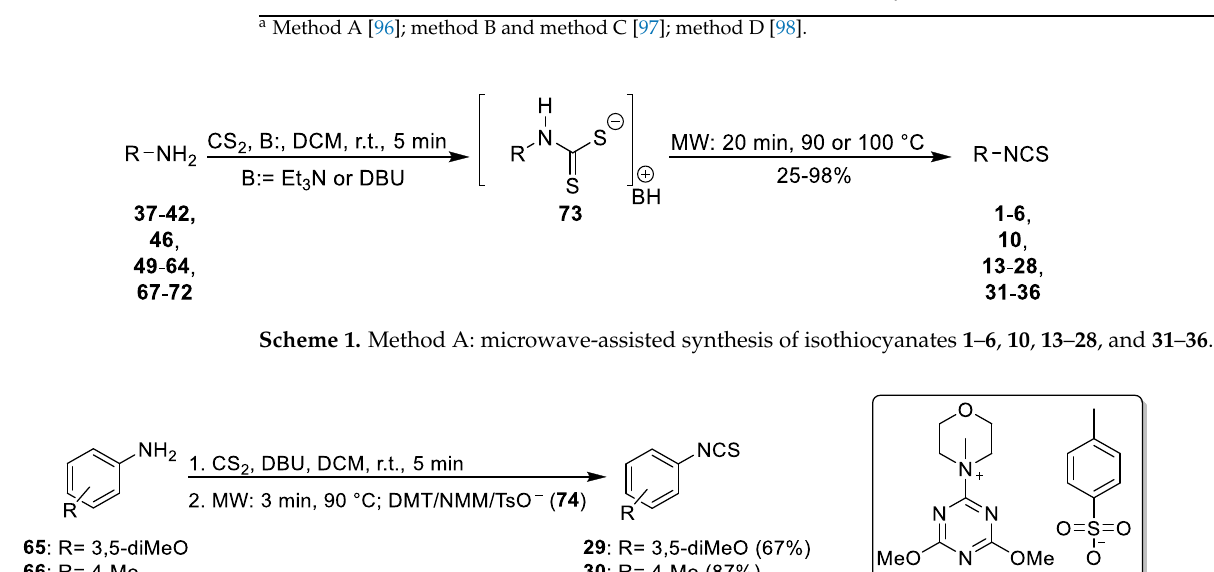
Scheme 2. Method B: microwave-assisted synthesis of isothiocyanates 29 and 30 using DMT/NMM/TsO − ( 74 ) as desulfurating reagent.